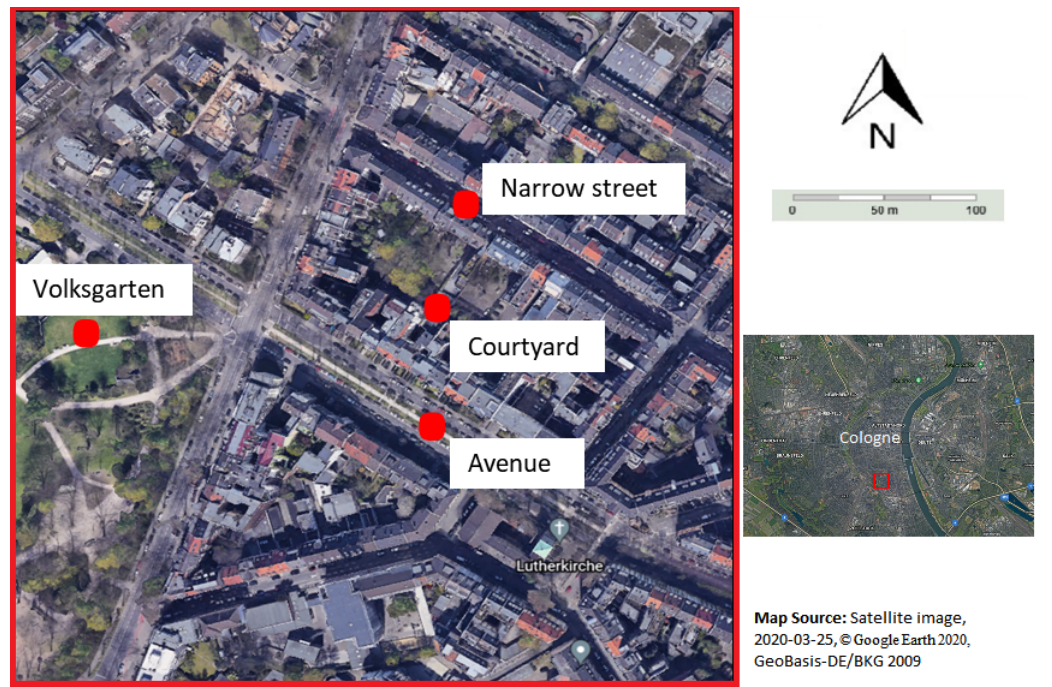
Figure 1. 16ha study area in the southern city of Cologne and its characteristic spatial units (satellite image: © Google Earth 2020).